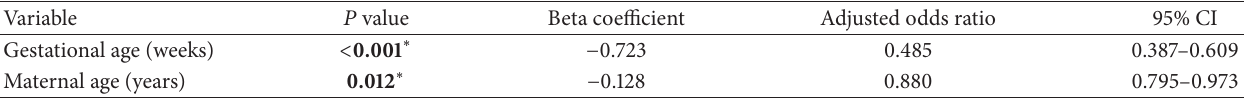
Table 4: Multivariate logistic regression analyses of risk factors for laser treatment in gestational age < 33 weeks infants. Variable 𝑃 value Beta